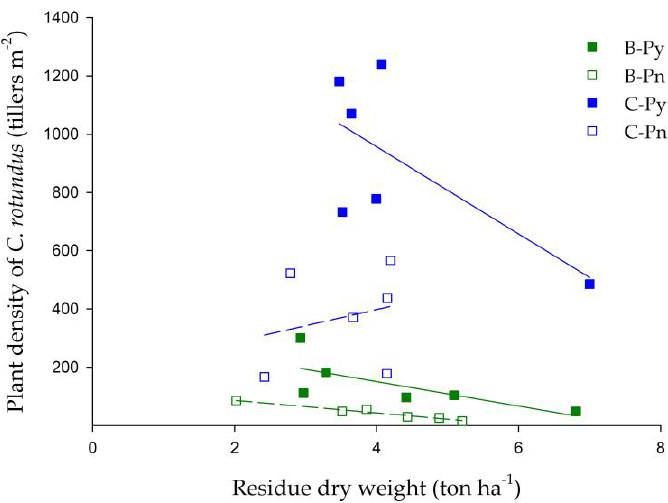
Figure 6. Relationship of plant density of CR (tillers m − 2 ) and residue dry weight (ton ha − 1 ). B-Py is BPr residue covered with the opaque plastic sheet, B-Pn is BPr residue covered without the opaque plastic sheet, C-Py is CR residue covered with the opaque plastic sheet and C-Pn is CR residue covered without the opaque plastic sheet.